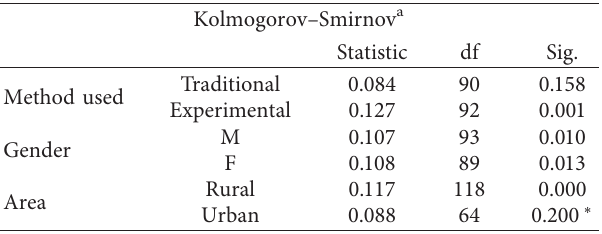
Table 3: Tests of normality of the pretest according to the method, gender, and